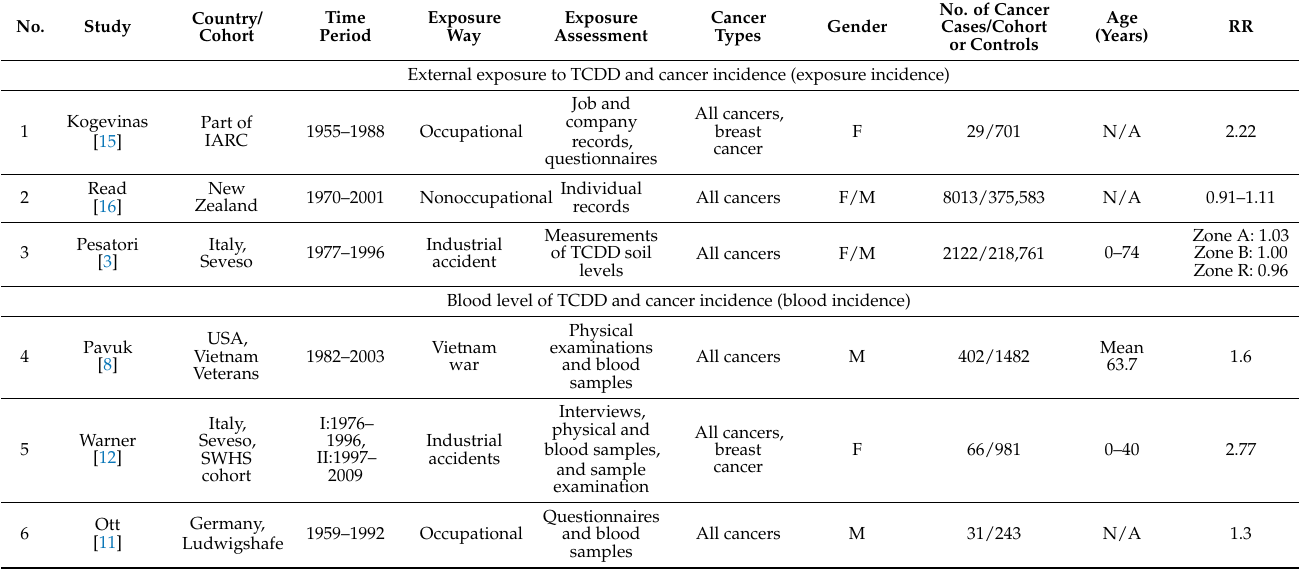
Table 1. Characteristics and results (RR) of some of the epidemiological studies on relationships between dioxins and human cancer development. Reproduced from Xu et al. [14], published by Sci. Rep .,